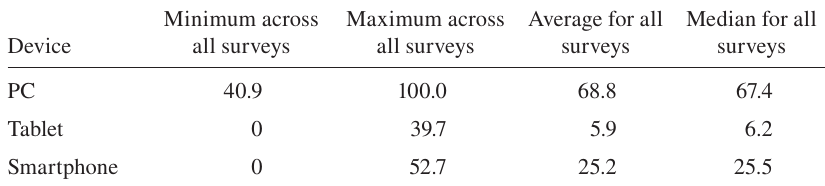
Proportion (in %) of different device types Minimum across Maximum across Average for all Median for all Device all surveys all surveys surveys surveys PC 40.9 Tablet 0 Smartphone